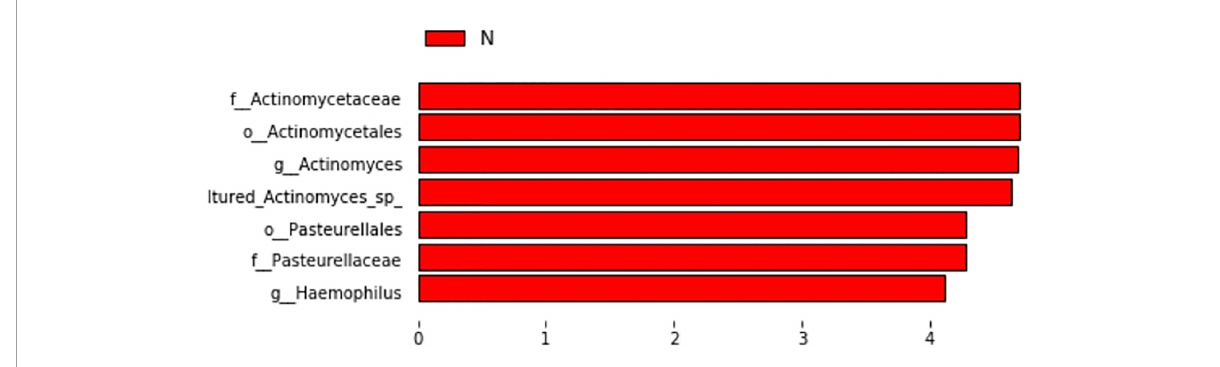
FIGURE10 Histogram of LDA value distribution of significantly different species in